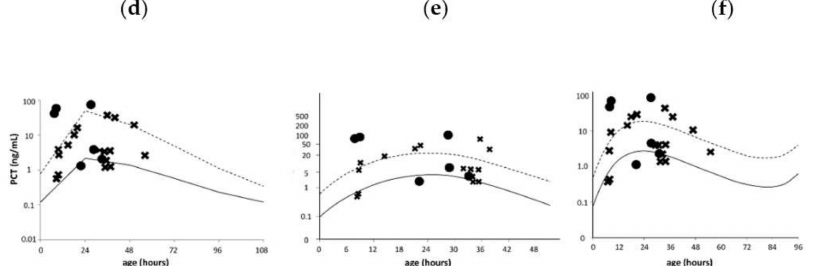
Figure 2. Serum PCT levels of term infants in the confirmed and non-infection groups. Serum PCT reference curves ( d – f ) are the serum PCT reference curves published by Fukuzumi et al. [17], Chiesa et al. (1998) [20] and Chiesa et al. (2011) [19]. Since the reference curve ( e ) was only available for neonates aged up to 48 h [20], two infants who were admitted and underwent blood sample collection from 48 to 72 h of age were excluded. Solid and dotted lines indicate the 50th and 95th percentile lines, respectively. • represents a PCT value for an infant with confirmed infection; × represents a PCT value for a non-infected infant. PCT,